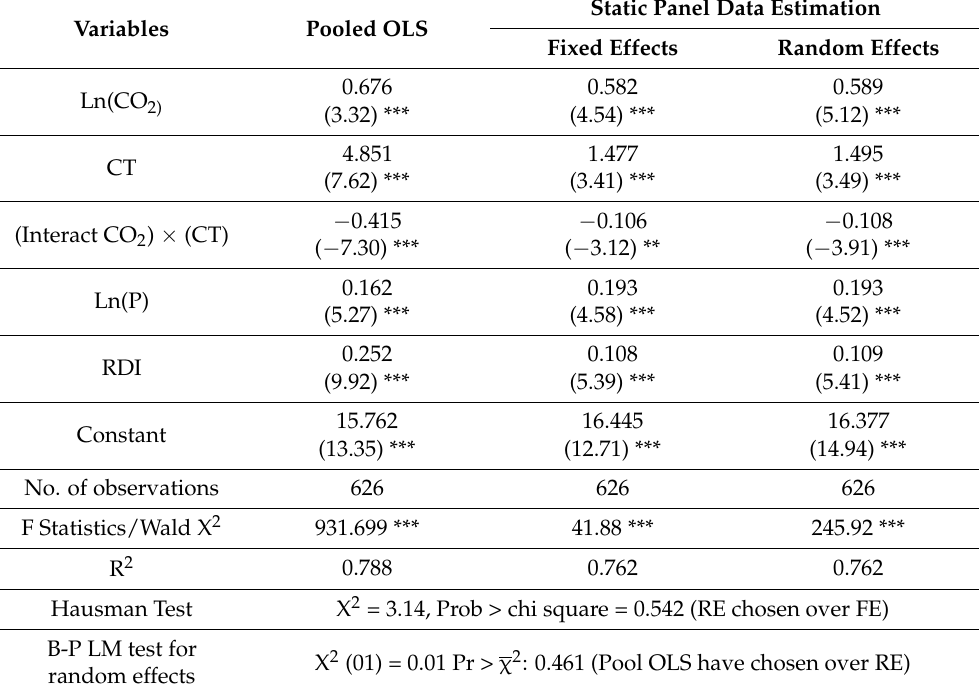
Table 2. Regression